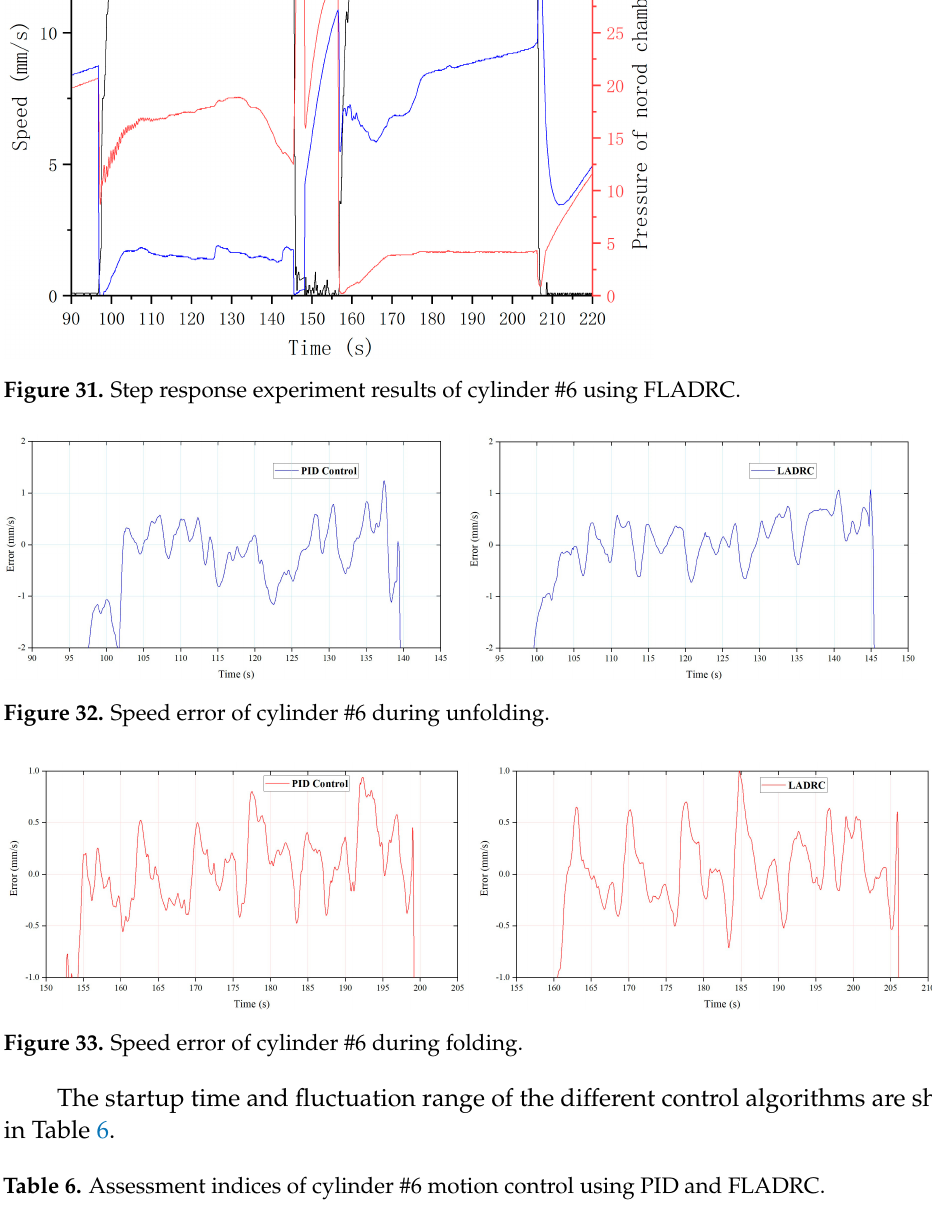
Figure 33. Speed error of cylinder #6 during folding.